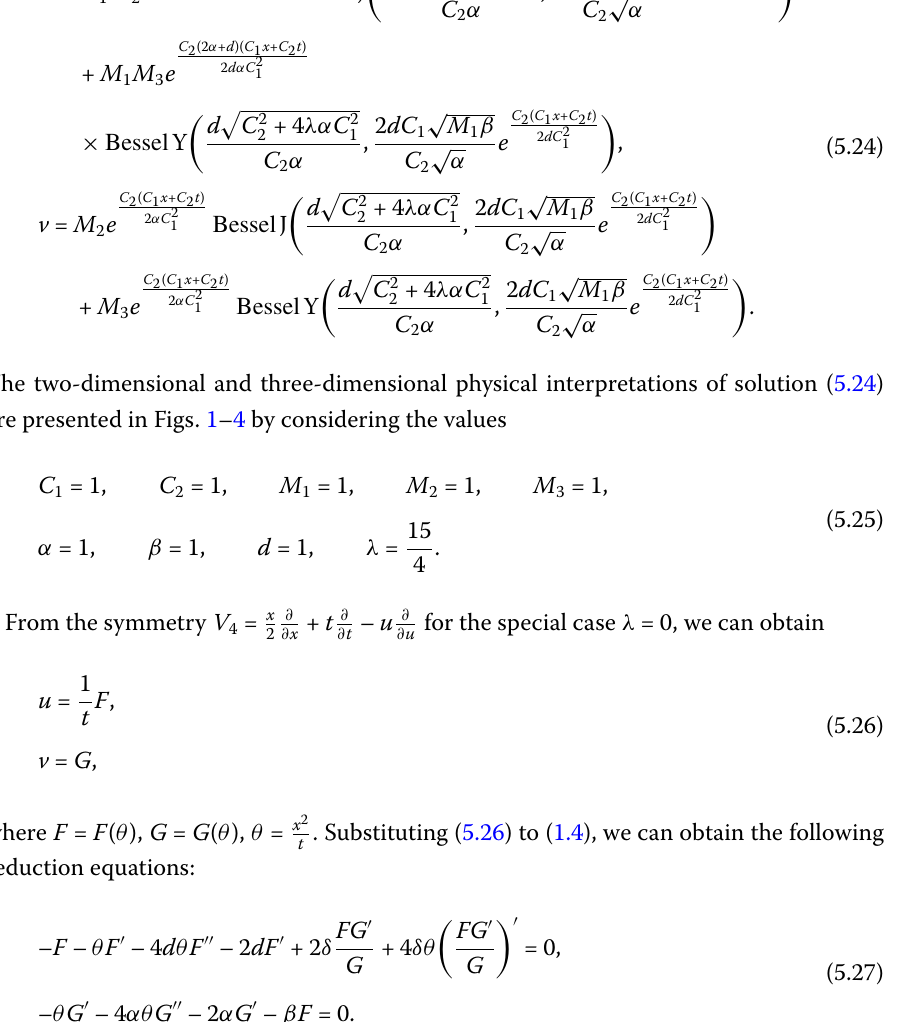
Figure 1 The solution u with the values in (5.25) when t =